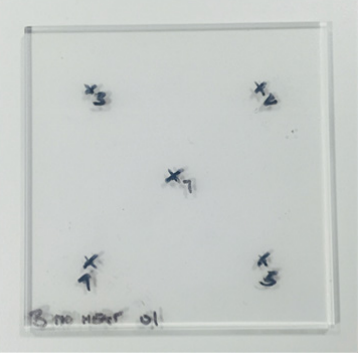
Fig. 5 test specimen with measuring points.